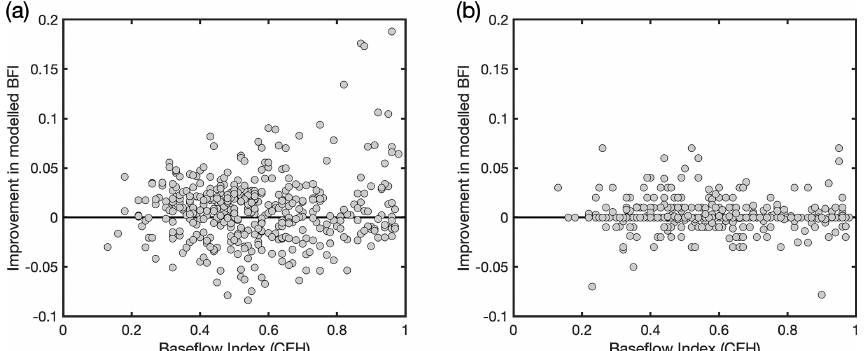
Figure A3. Scatter plots of improvement in modelled BFI as a function of observed BFI_CEH for (a) LR and (b) RF models. (Note this is the same as Fig. 7 but for